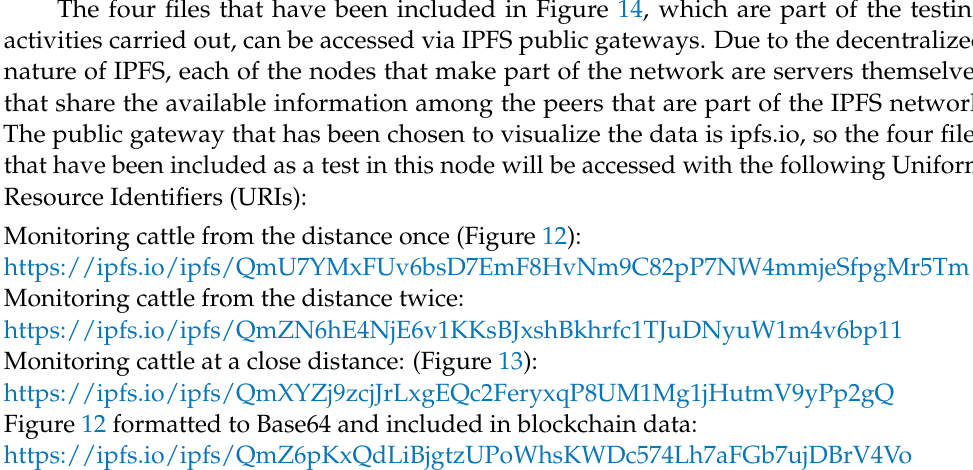
Figure 12 formatted to Base64 and included in blockchain